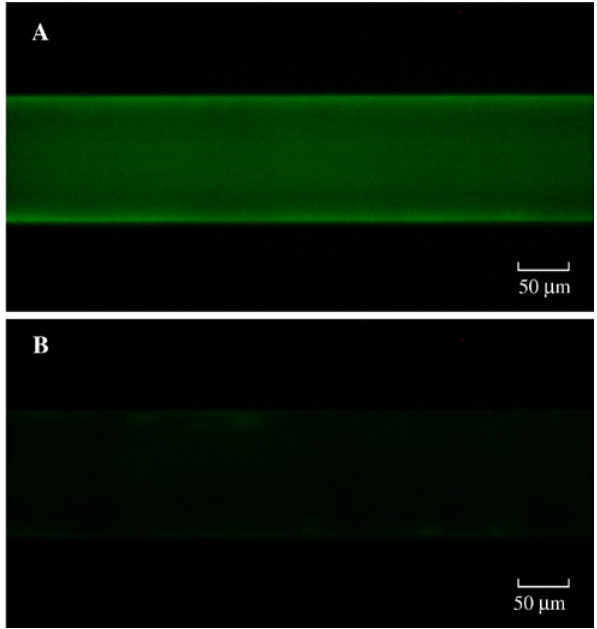
Figure 6: Fluorescent assay. Fluorescence images of the SMFs modified with HGFI (A) and bare SMFs (B) after they are respectively immersed in GAR–FITC antibody